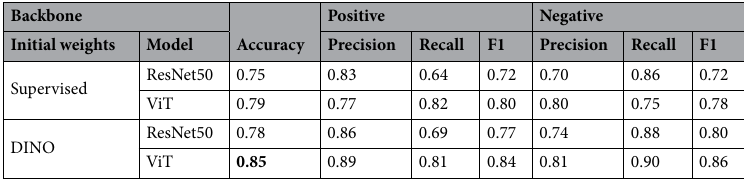
Table 6. DL classification results: analysis per frame. Best value is in